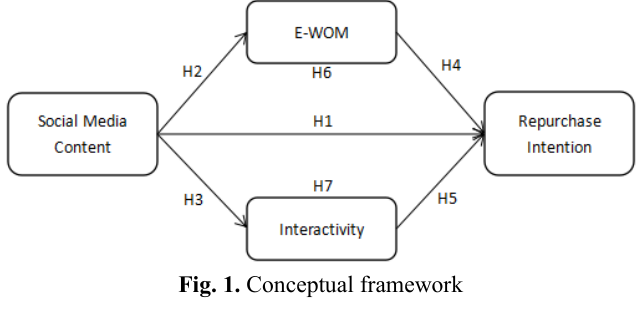
Fig. 1. Conceptual